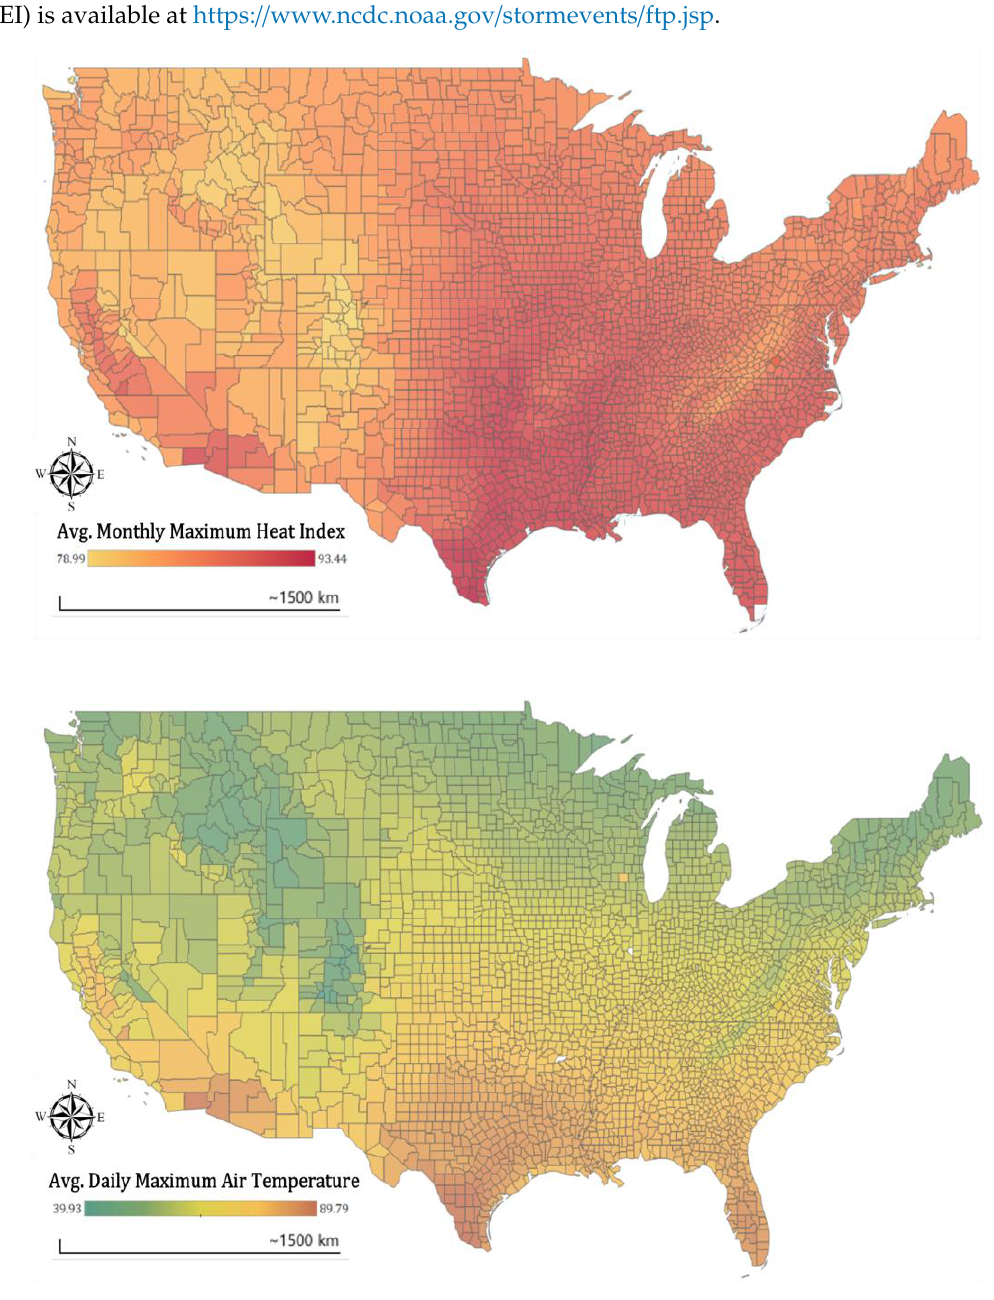
Figure 1. Summertime average maximum heat index vs. daily maximum temperature (1998–2011). Authors’ own illustration. Data: NLDAS Daily Air Temperatures and Heat Index, CDC [24].